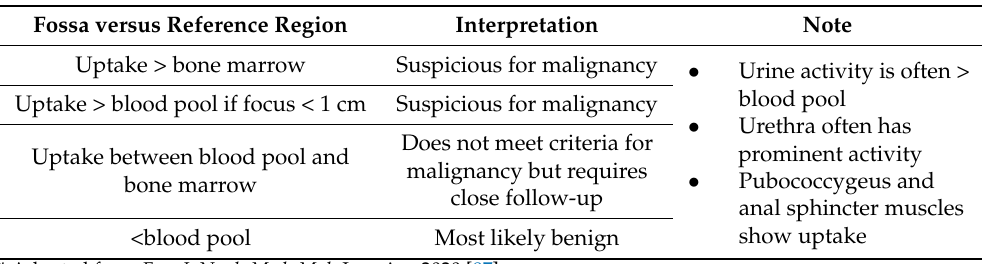
Table 5. Prostatectomy bed (fossa). Interpretive criteria for 18 F fluciclovine (Axumin ® ) for the prostatic fossa in patients post prostatectomy *.